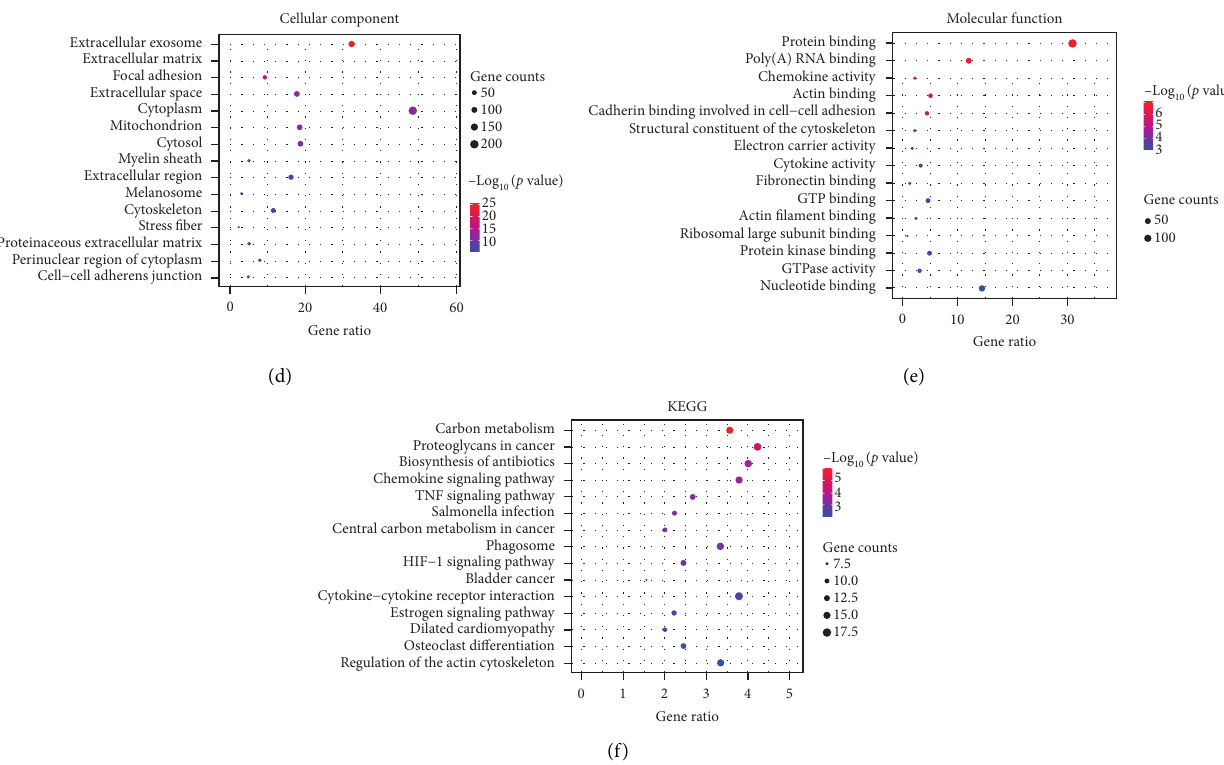
Figure 1: Bioinformation analysis from the GSE83472 dataset. (a) Volcano plot of DE-RNAs from the GSE83472 dataset. Red dot represented upregulated RNAs, and yellow dot represented downregulated RNAs. (b) Heat map of hierarchical clustering analysis for DE- RNA expression. Red represented greater expression, and blue represented less expression. (c–f) The top 15 significant KEGG pathways and GO terms related to the biological process, cellular component, molecular